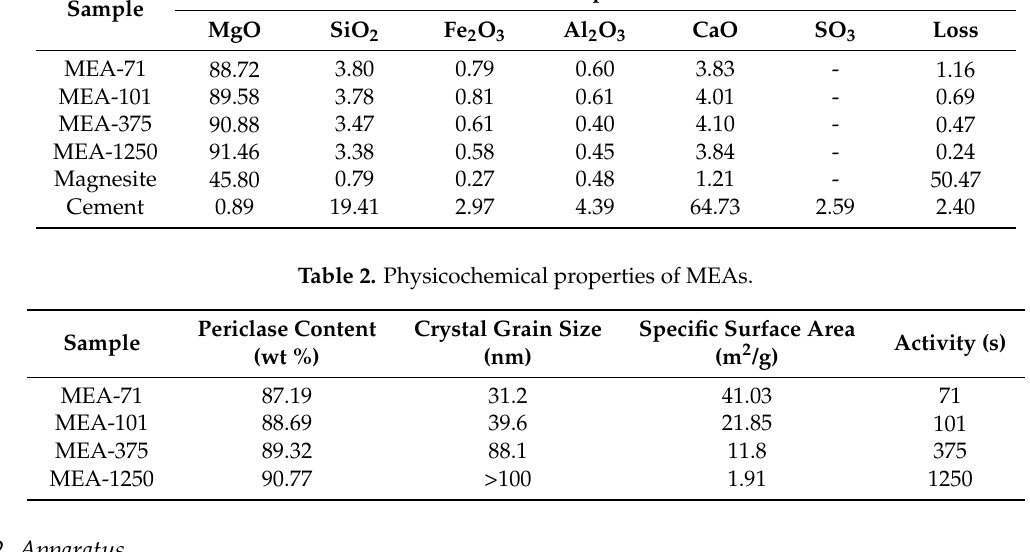
Table 2. Physicochemical properties of MEAs.